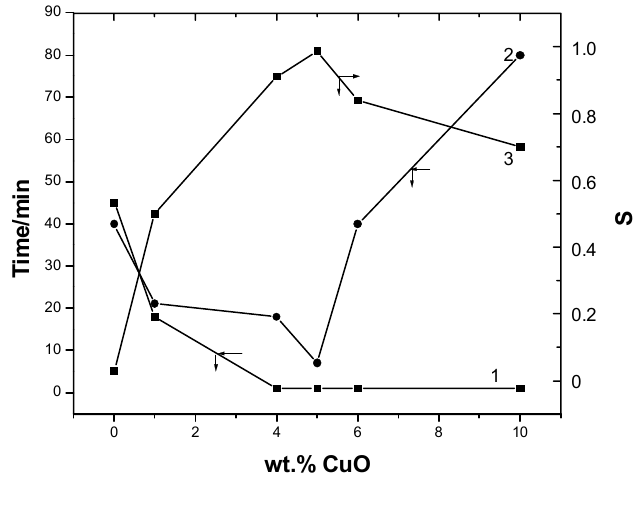
Figure 5. The effect of CuO loadings on response and recovery time and sensitivity. 1 recovery curve 2 response curve 3 sensitivity curve (150 o